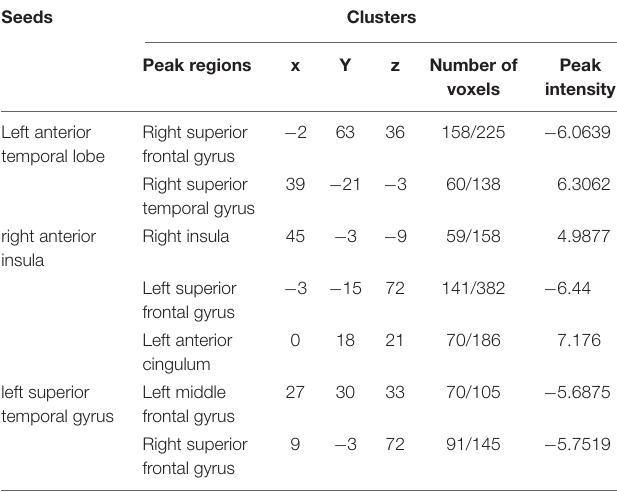
TABLE 3 | Regions of changed resting state functional connectivity in patients with SD compared with healthy